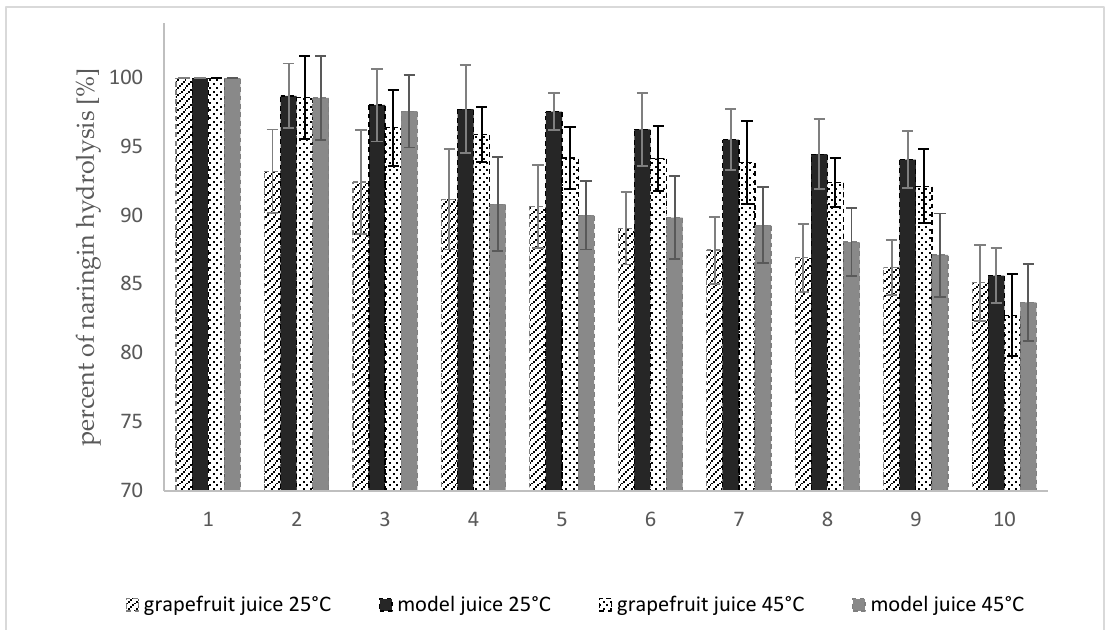
Figure 7. Degree of hydrolysis of naringin in grapefruit juice and model juice by naringinase crosslinked with dextran aldehyde based on 10 consecutive reaction cycles. Freshly squeezed grapefruit juice containing 383 µg·mL −1 of naringin.